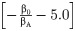
Histogram of biases of all bees.Biases of all of the 102 bees, tested for (A) the Entry condition and (B) the Exit condition. The polarity and magnitude of the bias of each bee is quantified by the parameter [−β0βA−5.0] (see ‘Materials and methods‘).